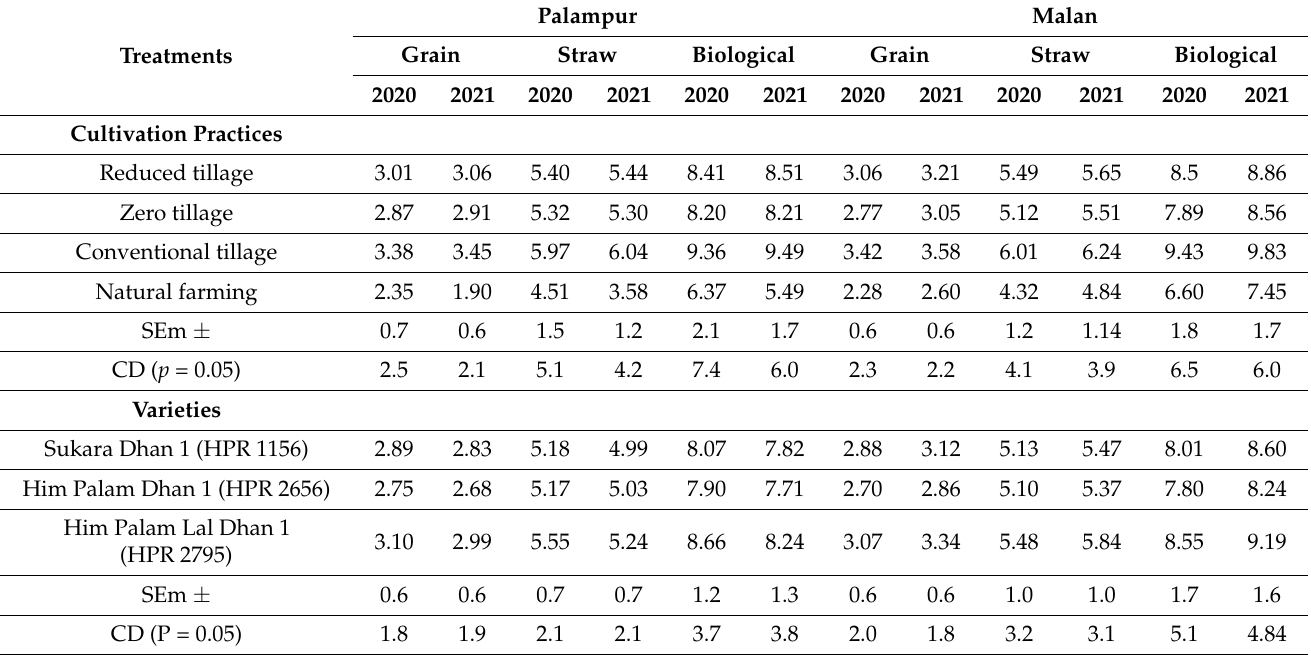
Table 2. Effect of cultivation practices on yield (t ha − 1 ) of different rice varieties at Palampur and